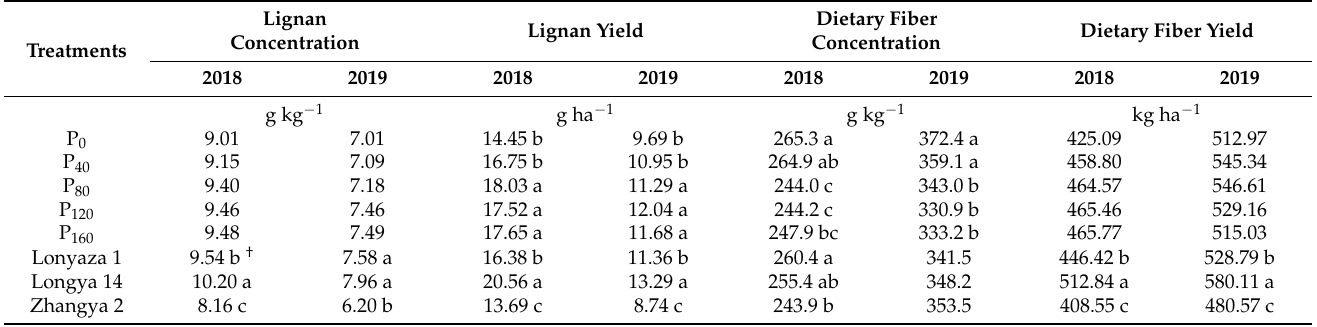
Table 3. Lignan and dietary fiber concentrations and yields for three cultivars and five phosphorus rates.